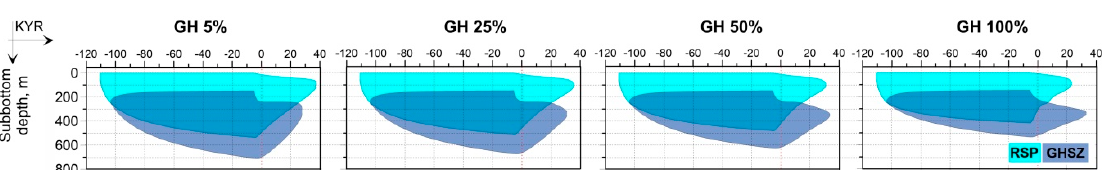
Figure 8. An example of a set of plots calculated according to Scenario 2 showing the effect of hydrate content on the evolution of permafrost and hydrate stability (see legend in Figures 5 and 6).